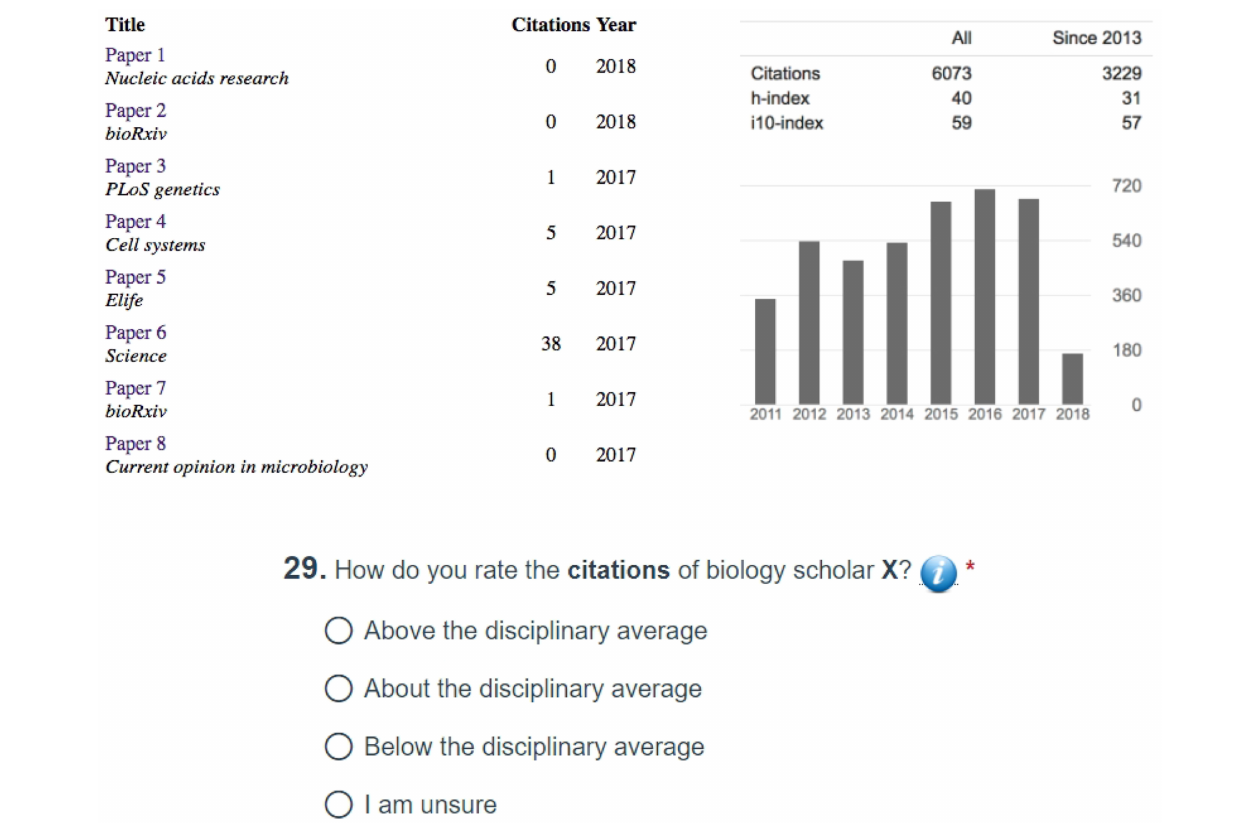
FIGURE 5 | Anonymized Google Scholar profile serving as the basis of comparison with the Raw and Normalized SP forms, when the survey is taken by respondents in Biology Departments. The publications are listed in reverse chronological order, and the respondents have to scroll down to see the full profile of the scholar under